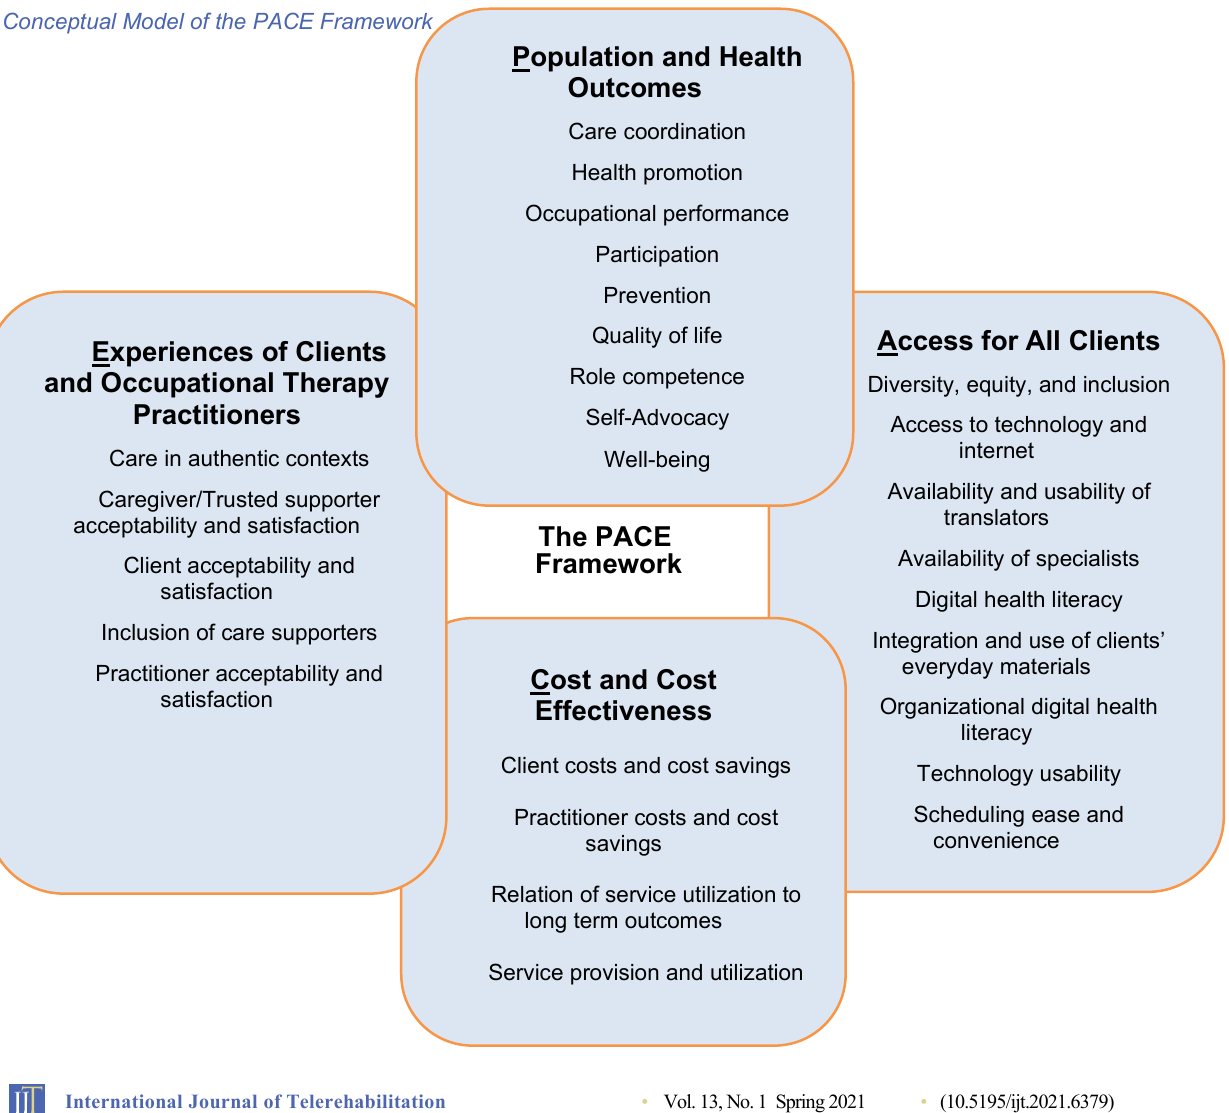
Figure 1 Conceptual Model of the PACE